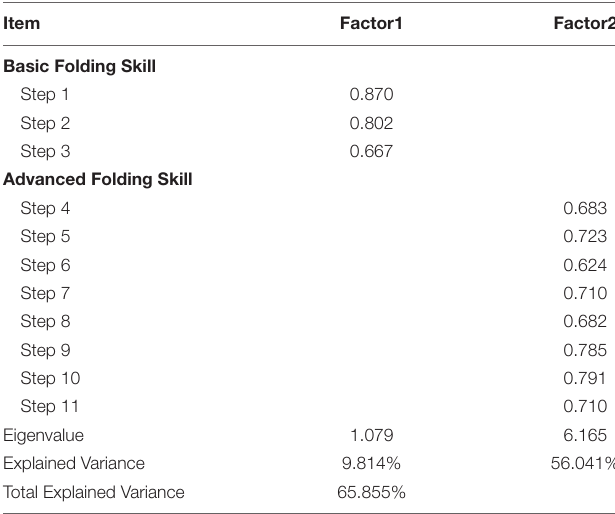
TABLE 1 | Exploratory factor analysis and confirmatory cluster structures for the paper folding